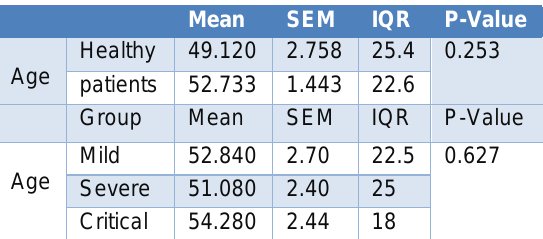
Table 2: Demographical characteristics of the